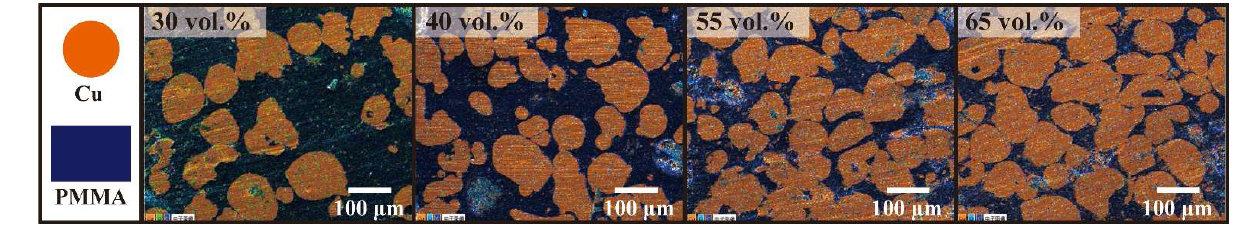
Figure 5. Distribution of 100 µm of Cu particles in the Cu/PMMA.